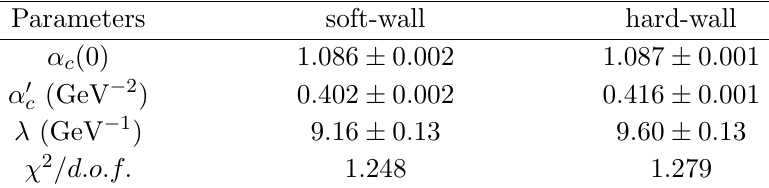
Table 2 . The (cid:12)tting results obtained with the di(cid:11)erential cross section data measured by the p TOTEM collaboration in the range, 2 : 76 (cid:20) s (cid:20) 13 TeV, and the total cross section data. The results of (cid:12)tted parameters and (cid:31) 2 =d:o:f: for the two data sets are shown in table